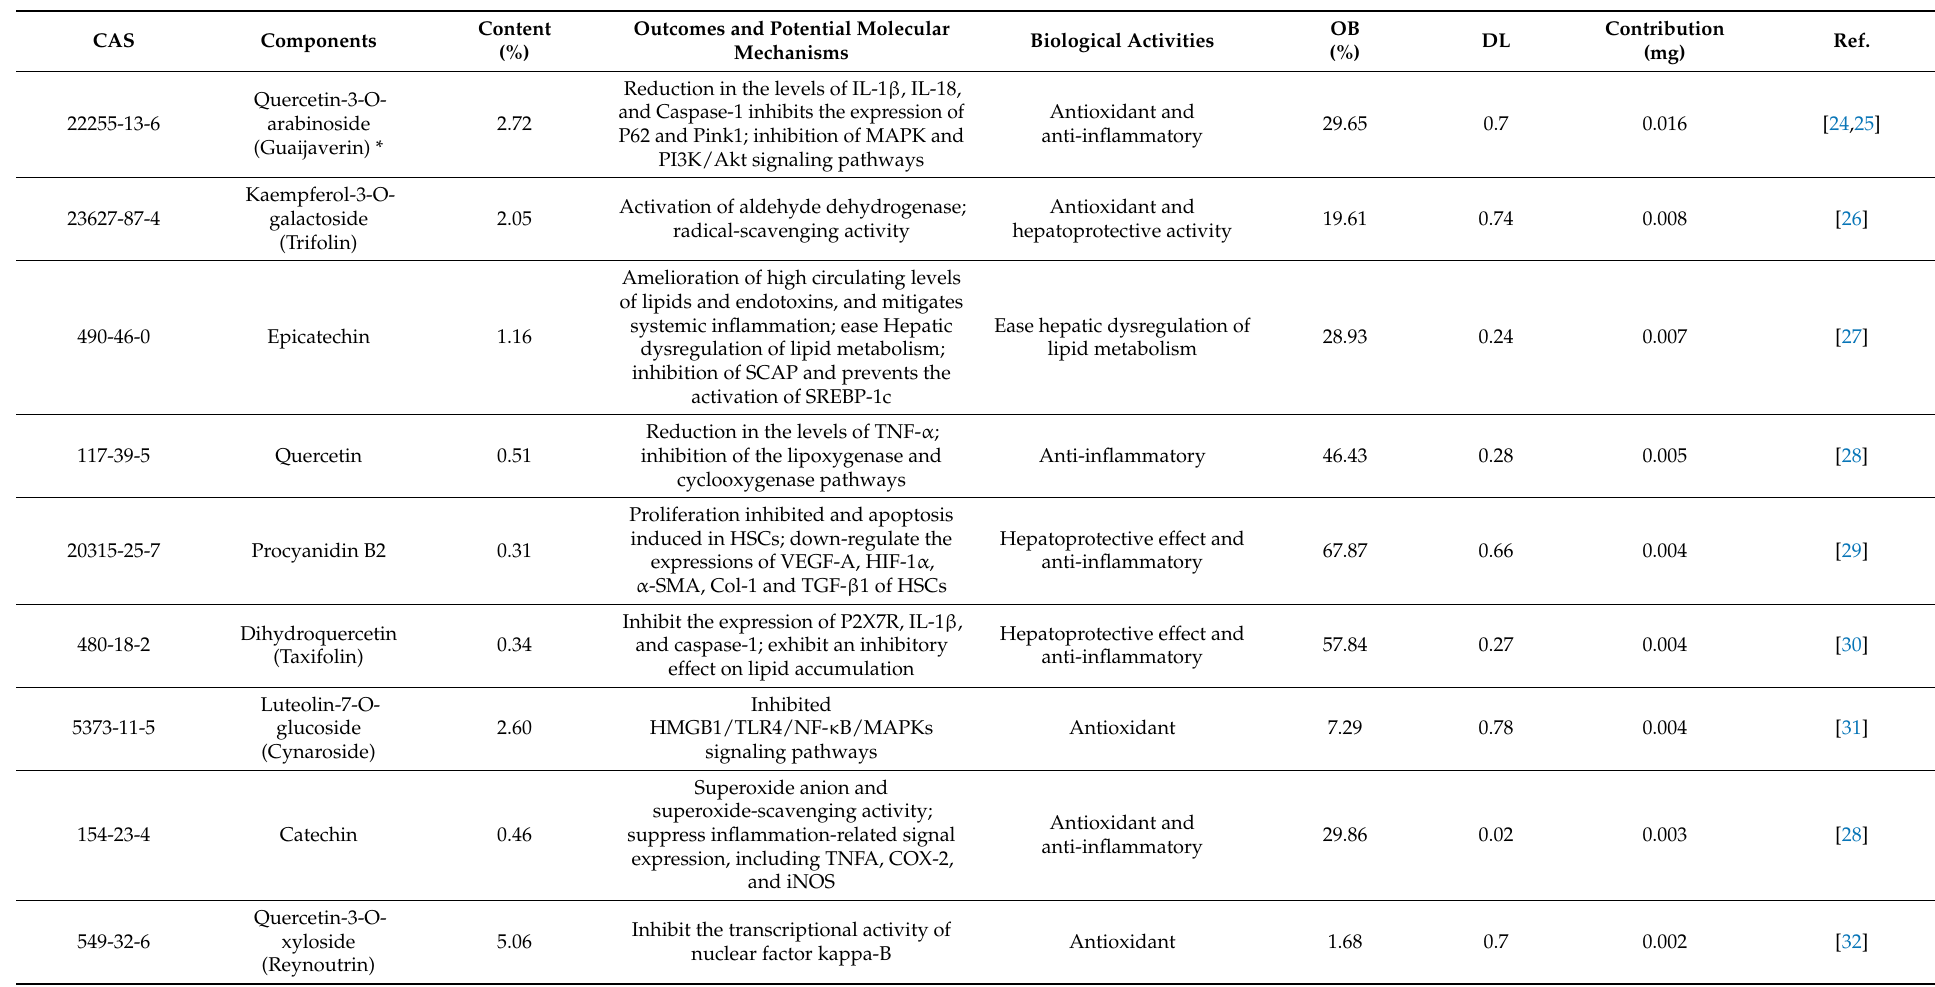
Table 1. Compounds in HTF which Related to Hepatoprotection, their content and biological